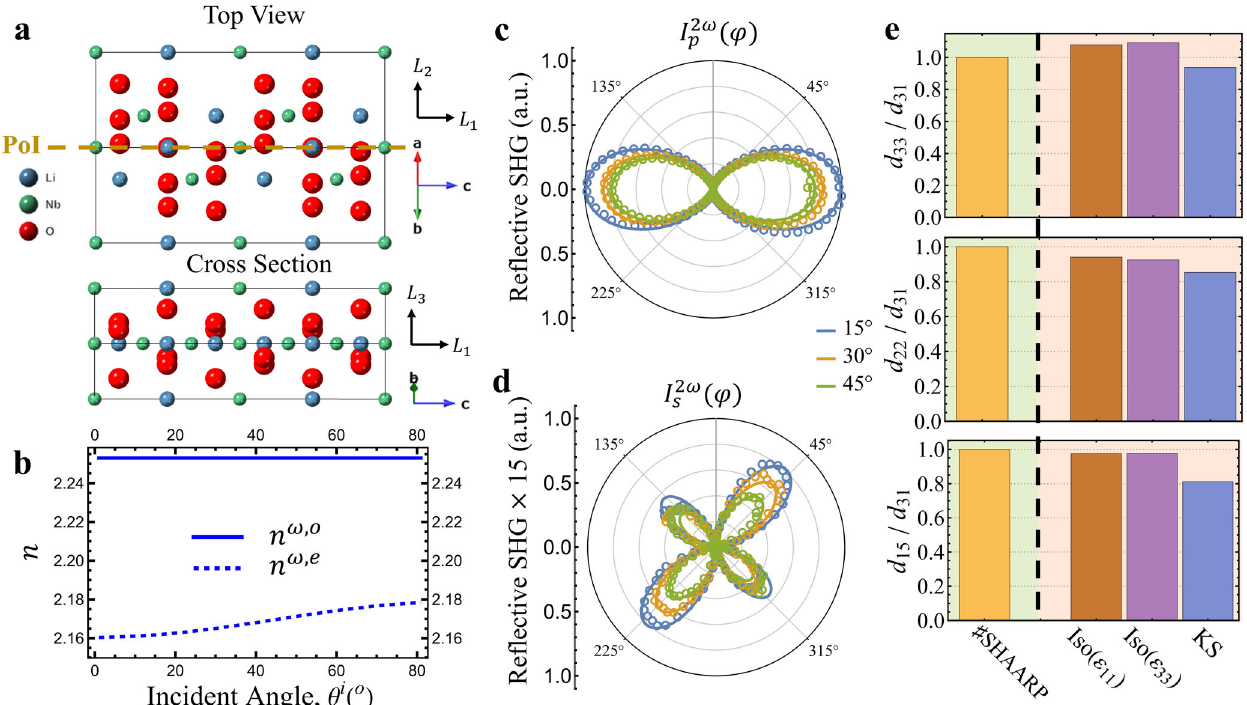
Fig. 5 Linear and nonlinear optical responses of LiNbO 3 (1120). a Crystal structure and experimental orientation. b The real part of the effective refractive indices at ω frequency as a function of incident angle ( θ i ). c and d p - and s -polarized second harmonic responses as a function of azimuthal angle ( φ ) at various incident angles ( θ i ). e Comparison of ratios of SHG coef fi cients between ♯ SHAARP (pale green background) and other forced approximations (pale orange background). Iso and KS, respectively, represent isotropic symmetry and Kleinman ’ s symmetry approximations, respectively. Iso ð ε ii Þ indicates that the component ε ii was assumed in all directions under the isotropic approximation, where i is the direction